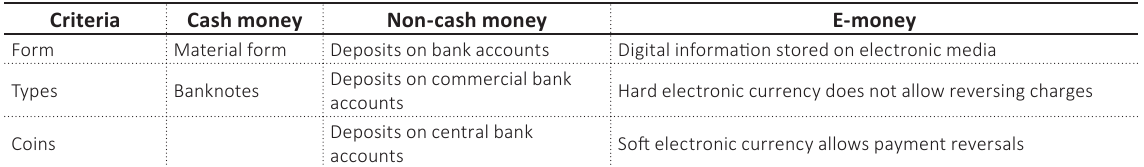
Table 1. Forms and types of cash, non-cash, and